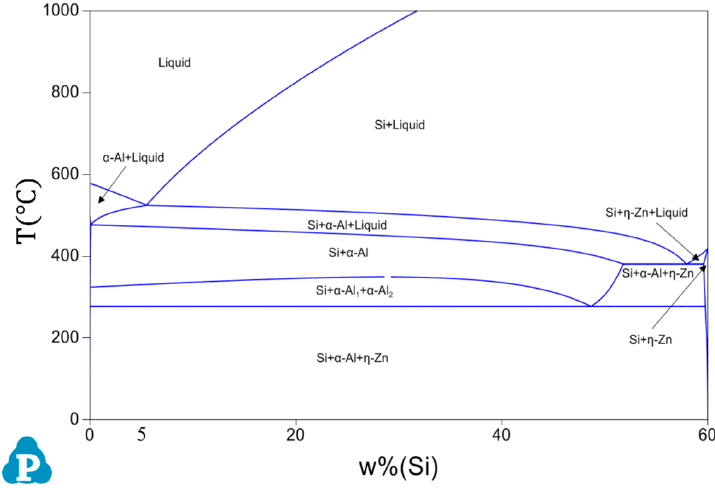
Figure 1. Polythermal section of Al-40Zn-xSi phase diagram calculated by Pandat software [31] . Figure 2 is the phase fraction variation (Si, α -Al 1 , α -Al 2 , Zn and liquid) with temper- ature for the Al-40Zn-1Si, Al-40Zn-3Si, Al-40Zn-5Si and Al-40Zn-6Si alloys under equilib- rium solidification calculated by Pandat software. It can be seen from Figure 2 that the four phase fractions with variations in temperature for the different Si content alloys were roughly the same. When the silicon content was 1%, 3% and 5%, all the silicon phases were eutectic Si. When the silicon content increased to 6%, the primary phase was no longer α -Al, but a small part of primary silicon. Therefore, it can be inferred that the silicon phase in Al-40Zn-6Si is composed of eutectic Si and primary Si. After the Al-Si eutectic reaction, the α -Al decomposed into α -Al 1 and α -Al 2 , which had the same structure but different compositions. Then, α -Al and η -Zn eutectoid formed by the eutectoid reaction of α -Al 2 with decreasing temperature. When cooled from 275 °C to room temperature, the solubility of zinc in α -Al decreased from 31.6% to 1.14%, and the solubility of aluminum in η -Zn decreased from 0.6% to 0.05%. Figure 2. Phase fraction variation with temperature for Al-40Zn-xSi gold under equilibrium solidi- fication calculated by Pandat software: ( a ) Al-40Zn-1Si, ( b ) Al-40Zn-3Si, ( c ) Al-40Zn-5Si, ( d ) Al- 40Zn-6Si.